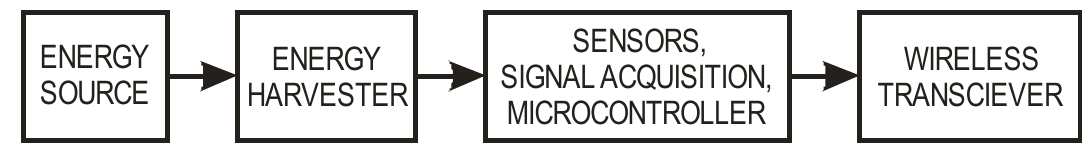
Figure 7. The block diagram of autonomous wireless